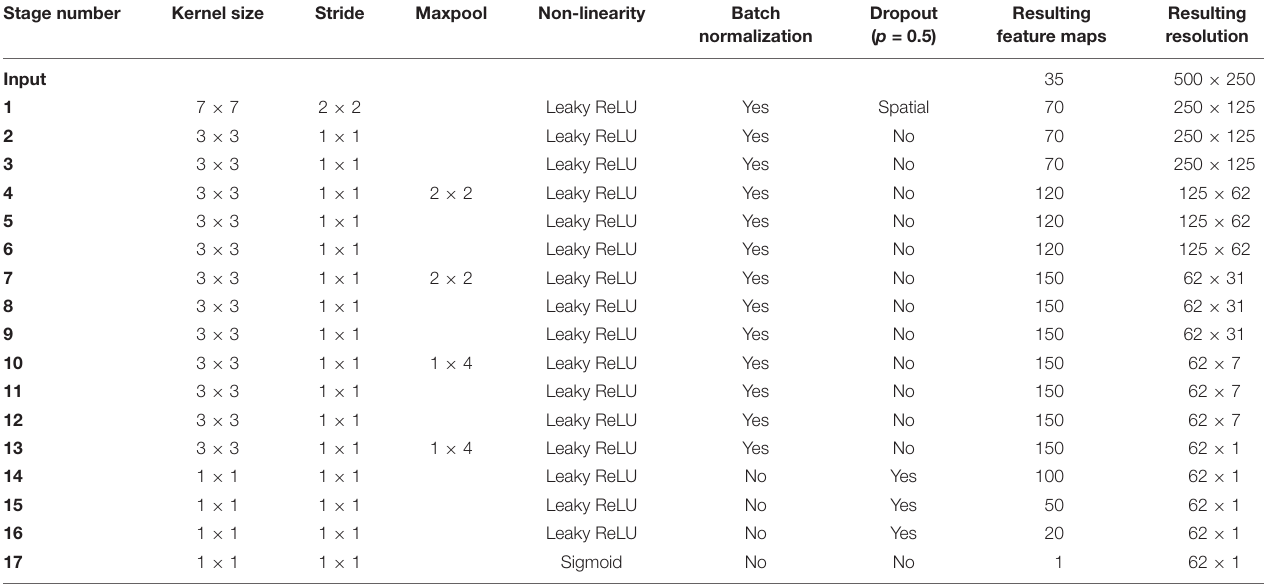
TABLE 2 | Neural Network Architecture consisting of 17 stages, each of which contains a convolutional layer followed by a number of optional layers including max pooling. Stage number Kernel size Stride Maxpool Non-linearity Batch